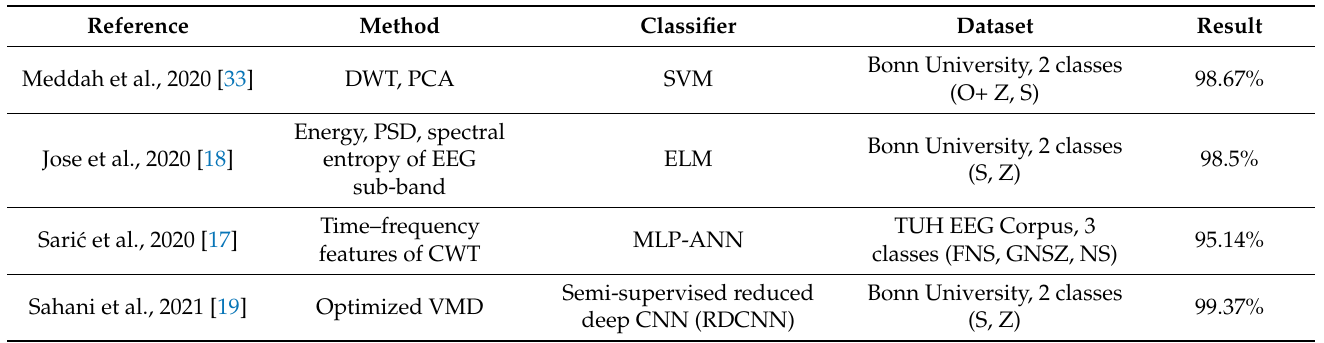
Table 2. Comparison with previous